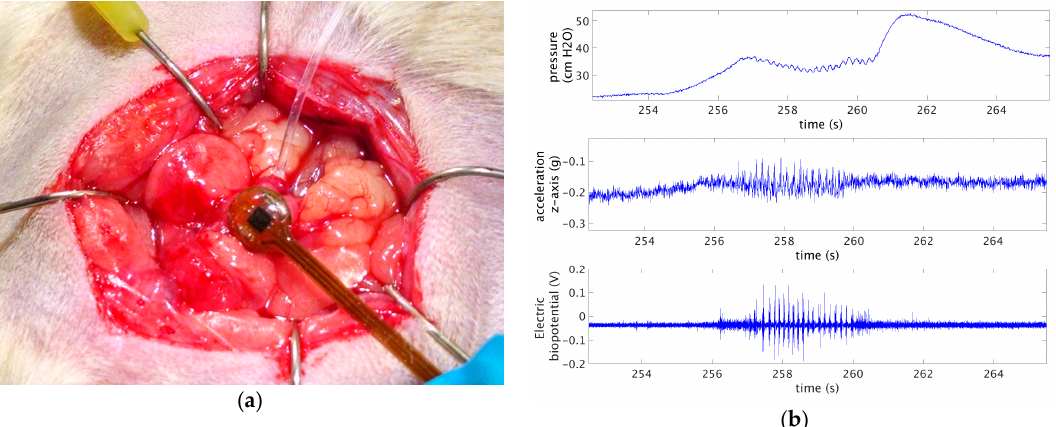
Figure 4. ( a ) Sensor implanted in a rat’s bladder; ( b ) Pressure, Z-component of the acceleration and EMG recorded during a voiding